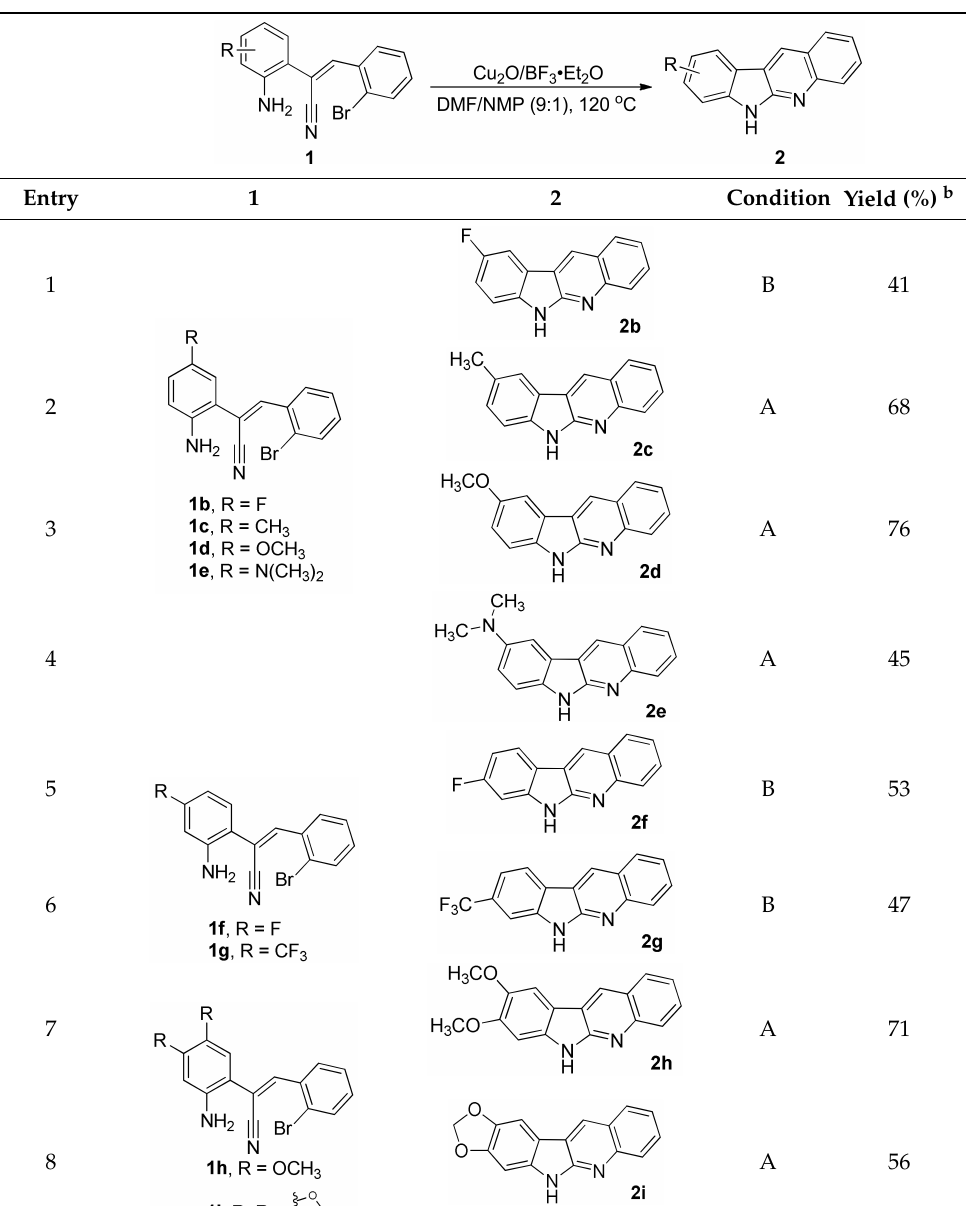
Table 2. Reaction scope a